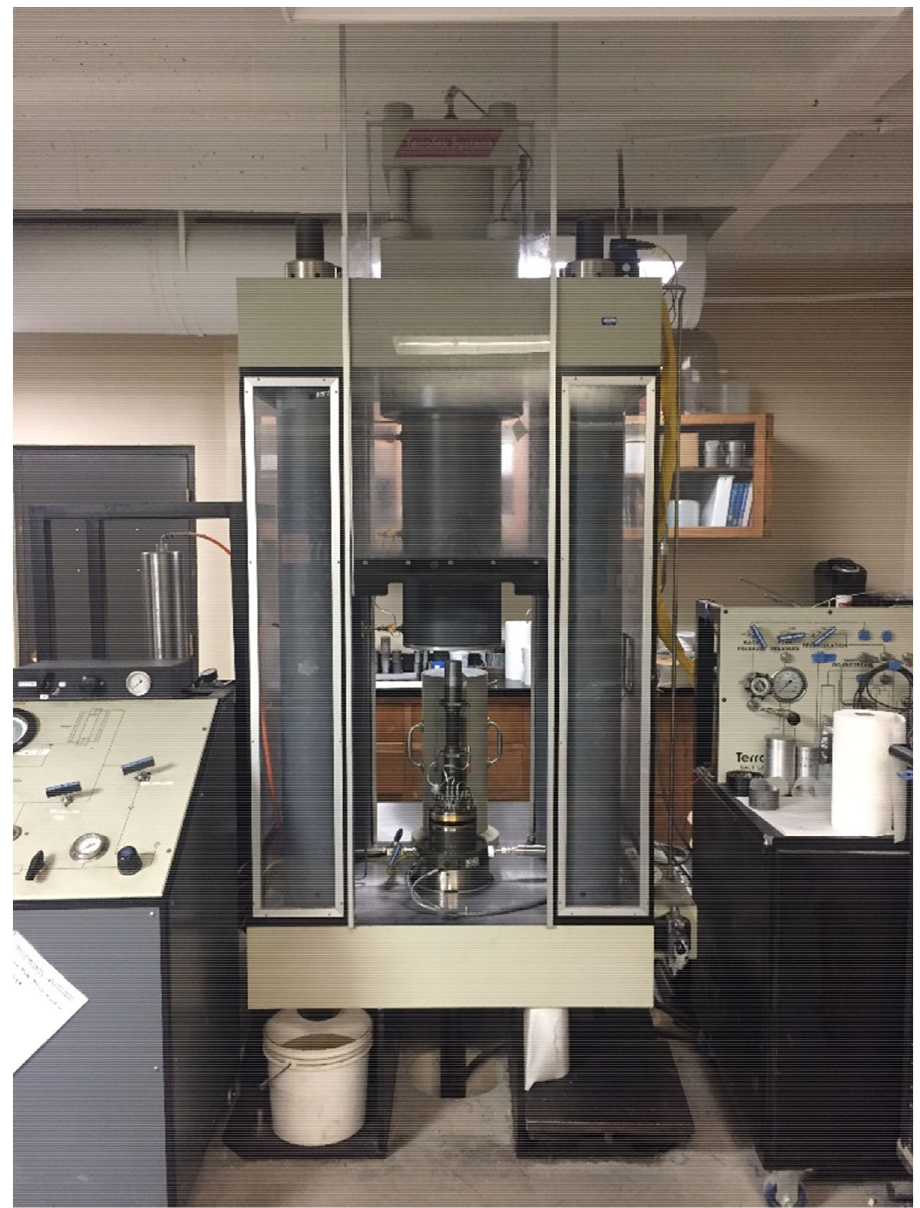
Fig. 1 Triaxial test machine at Montana Tech used for testing the coal